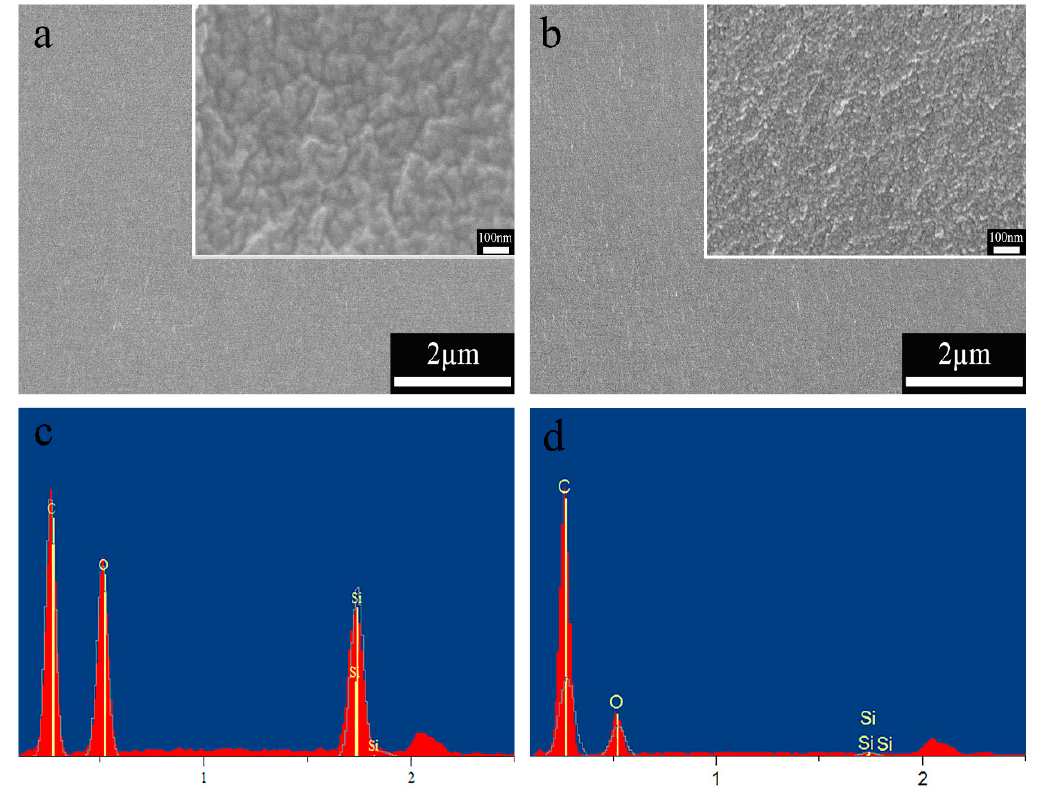
Figure 10. SEM images of the fractured surface of SPF-4 before ( a ) and after HF-etching ( b ). Higher magnified images were inserted, respectively. The EDX result is correspondingly shown below in ( c ) and ( d ).